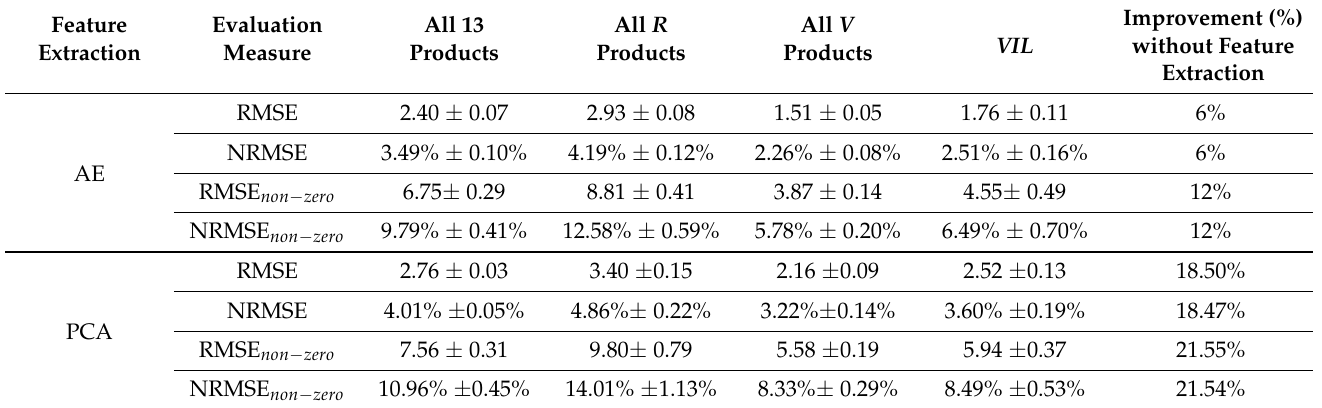
Table 3. Experimental results obtained using NowDeepN with a previous feature extraction step. 95% CI are used for the results. The last column illustrates the improvement achieved applying NowDeepN on the original data, considering all 13 radar